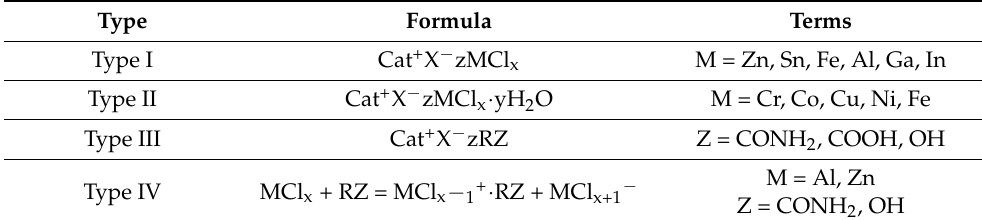
Table 1. Classification of DES. Adapted from